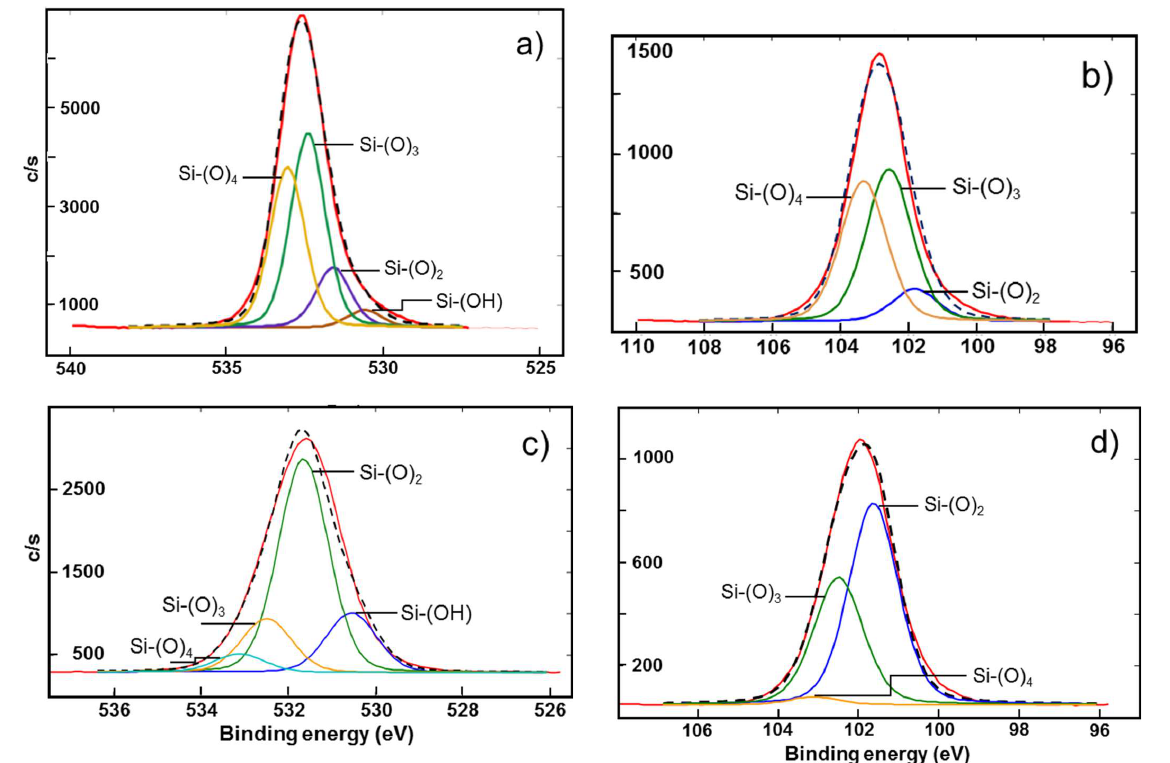
Figure 8. Curves fitting of XPS spectra of O1 s ( a , c ) and Si 2p ( b , d ). Laser ablation of PDMS with 266 nm: ( a , b ) in air with fluence 4.3 J.cm −2 ; ( c , d ) in water with fluence 28.07 J.cm −2 . Dashed line is the fitting curve.